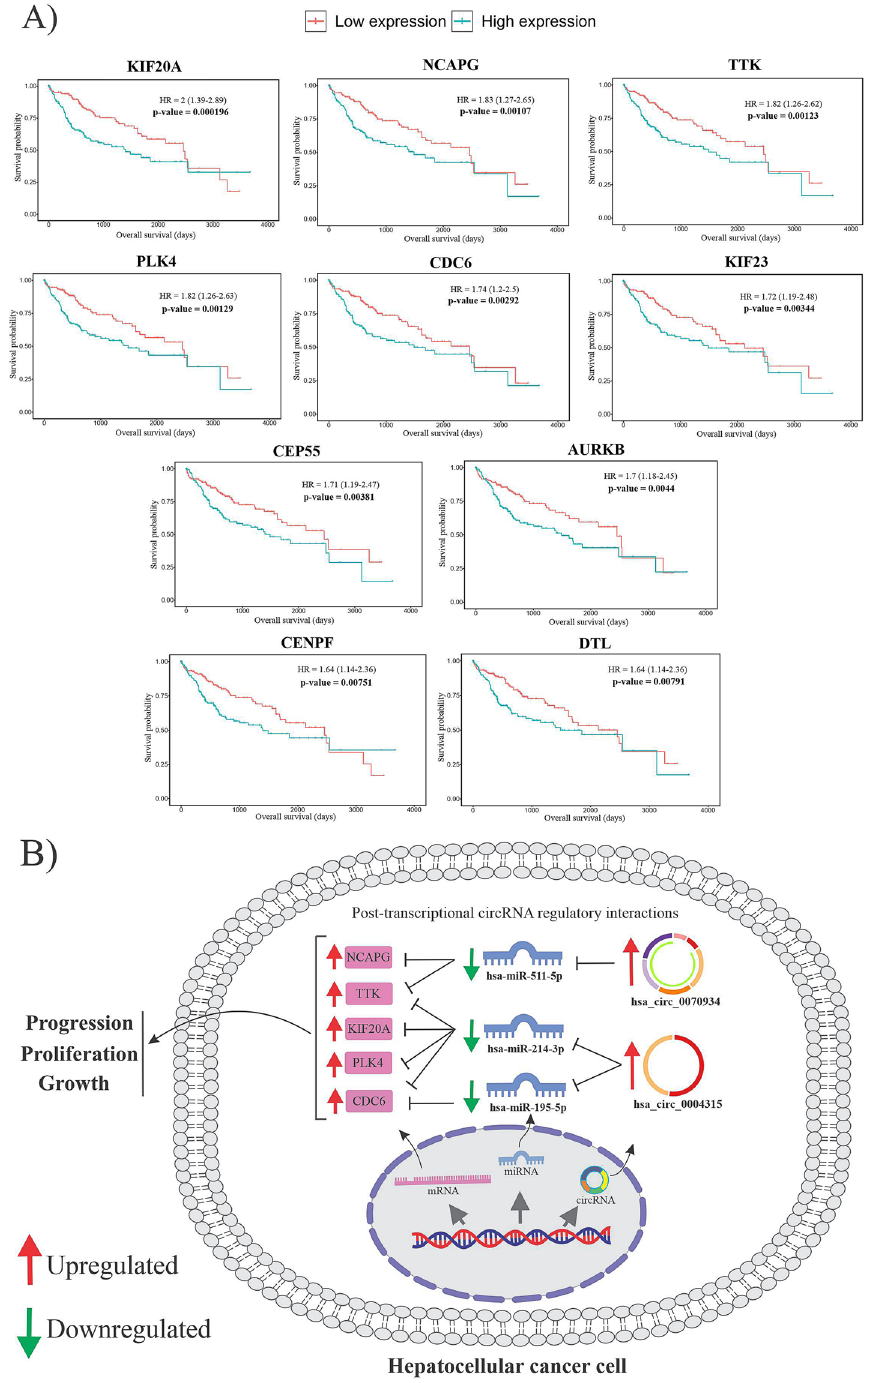
Figure 10. (A) The overall survival time of ten hub genes. In Kaplan–Meier plots, red lines indicate patients with lower hub gene expression, whereas green lines indicate greater hub gene expression. ( B) The figure demonstrates a schematic illustration of the DECs-FImiRNAs-FImRNA regulatory network for five final hub genes located inside the cytoplasm. The upregulation of two DECs causes the downregulation of three miRNAs, limiting miRNA-mediated hub gene degradation, and HCC may develop due to hepatic overexpression of these five hub